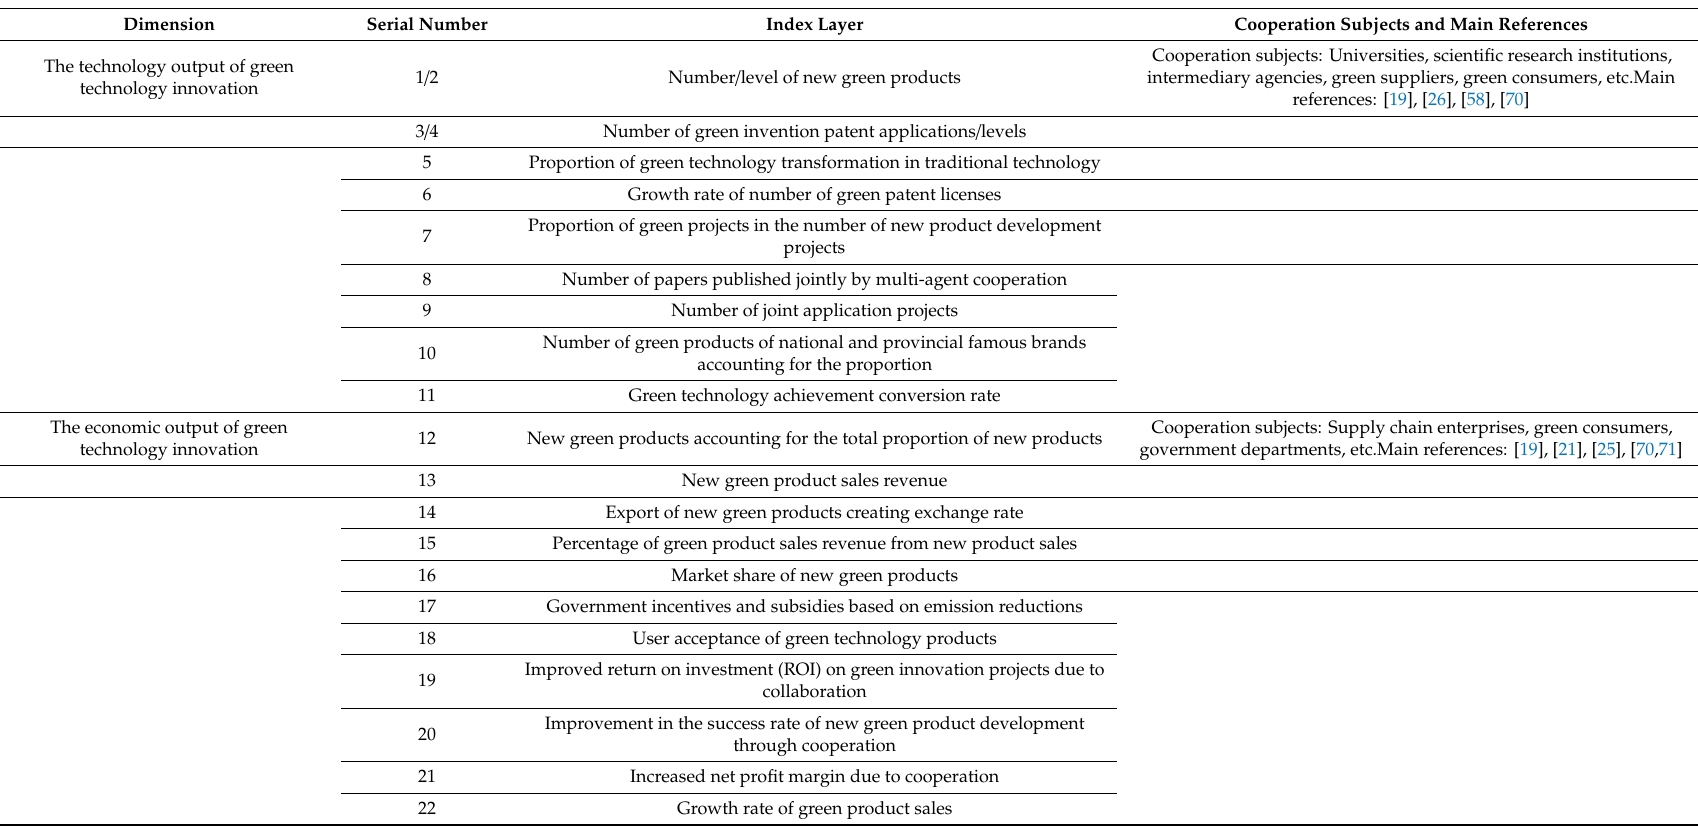
Table 1. The initial evaluation index system of the green technology innovation performance of manufacturing enterprises under multi-agent cooperation.